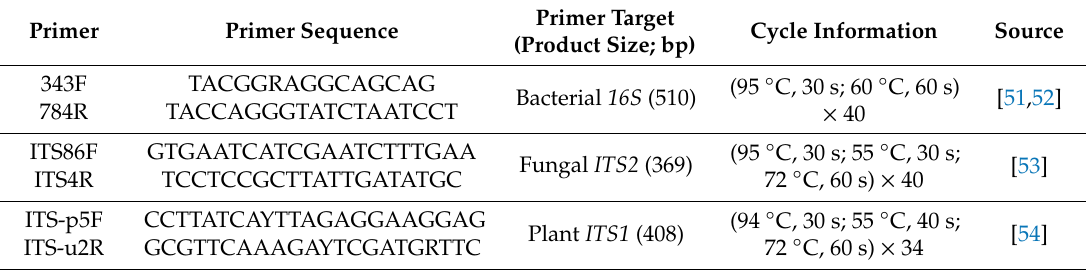
Table 1. Primer sequences used for amplification and quantification of bacterial, fungal, and plant DNA